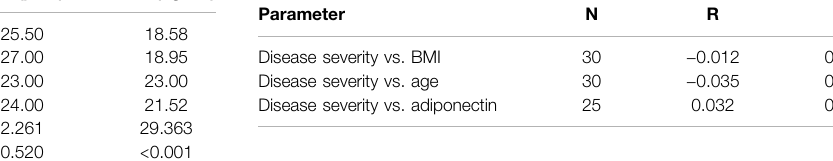
TABLE 1 | Anthropometric values in different hemoglobin phenotype groups. Group